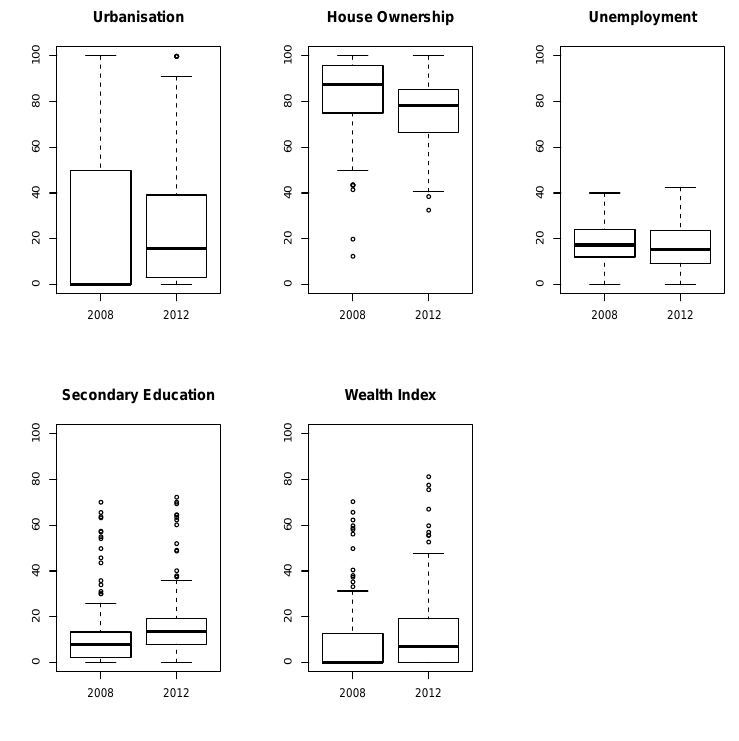
Figure 3 – Socio-economic and urbanisation variables across Tanzania districts at the first and third wave of the